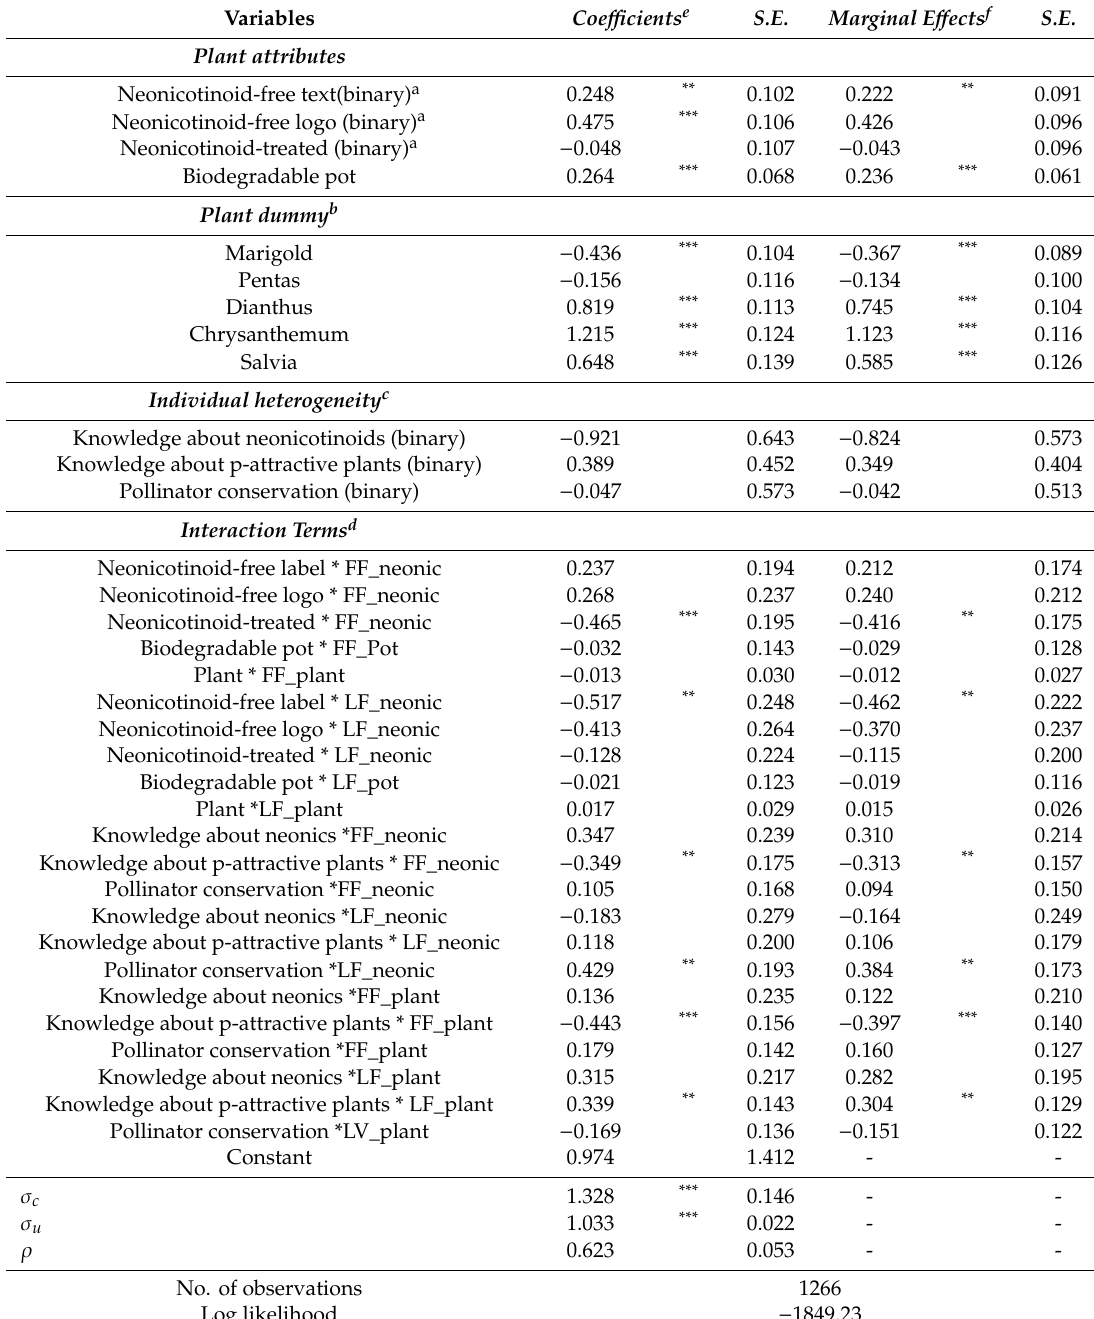
Table 6. Gaze cascade e ff ect on choice: random e ff ects tobit model.